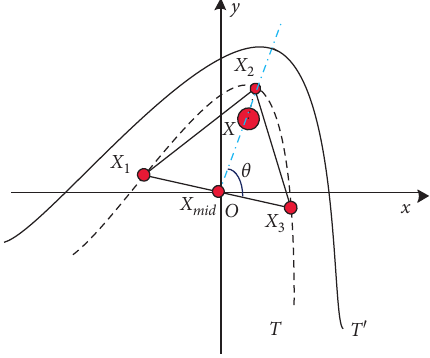
Figure 6: Matching angle diagram.